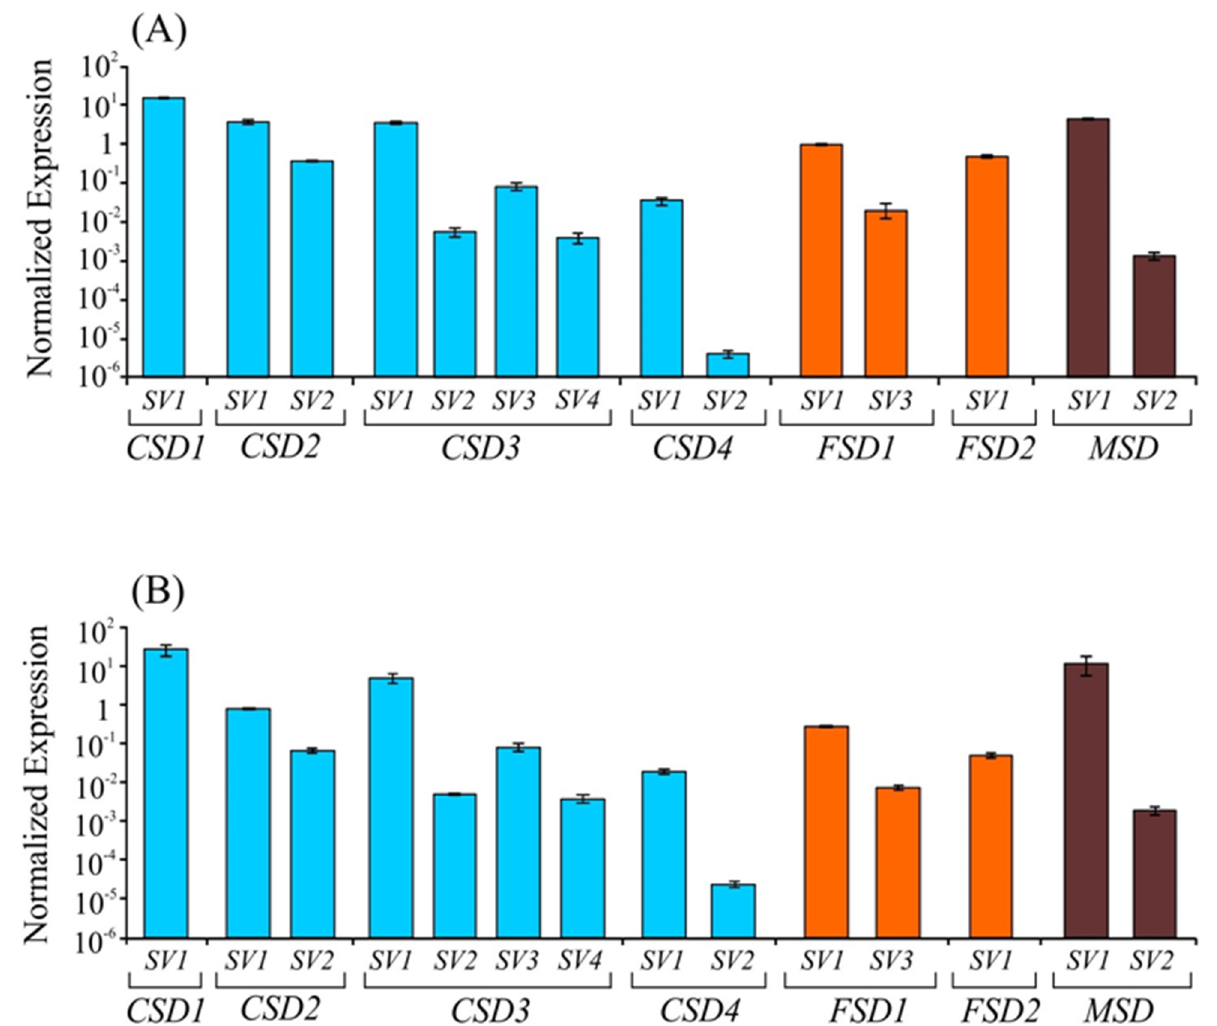
Figure 2. Basal relative transcript abundance of various splice variants of CSDs , FSDs , and MSD in shoot ( A ) and root ( B ) tissue. The transcript abundances shown on Y -axis were normalized using OsActin as a reference gene as per Schmittgen and Livak [28]. The data is presented as mean normalized transcript level ± SD of two repeats of independent biological replicates (each biological replicate had three technical replicates).